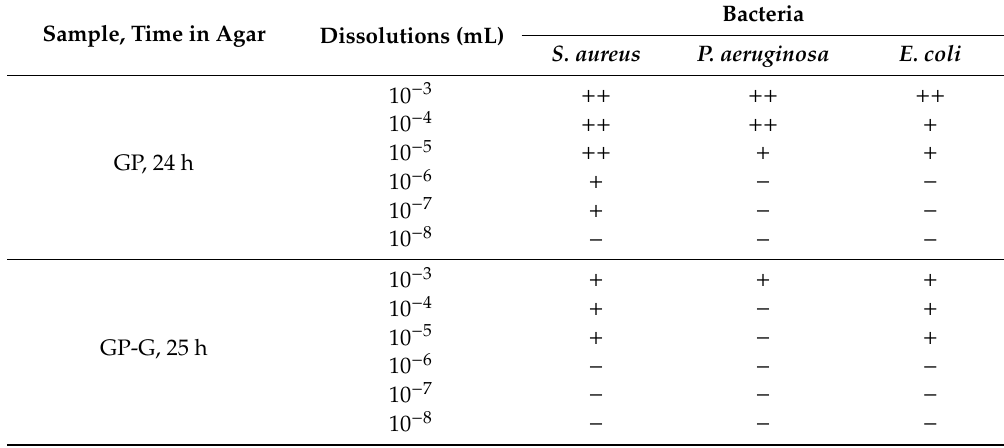
Table 6. Bacterial growth inhibition capacity of GP (24 h) and GP-G (25 h) in bacteria-rich agar solutions. Sample, Time in